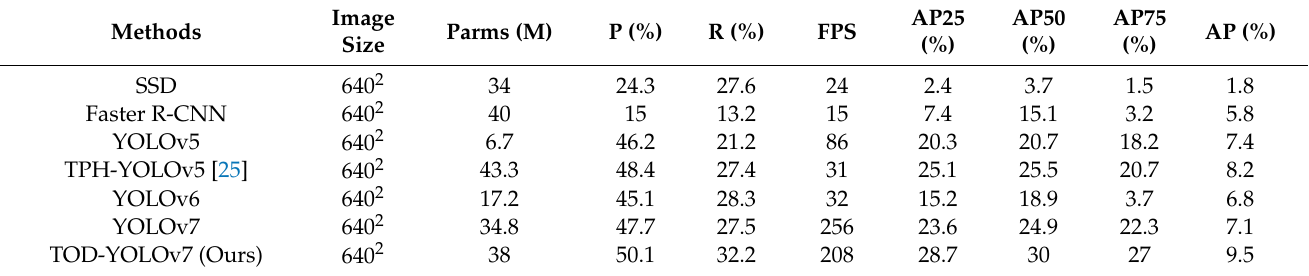
Table 2. The comparison of the performance with mainstream object detectors on TinyPerson